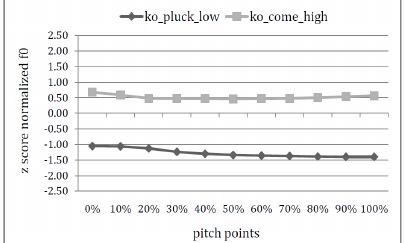
Figure 6: Normalized pitch contours for [ko], (n=20{5 speakers*4 iterations each})